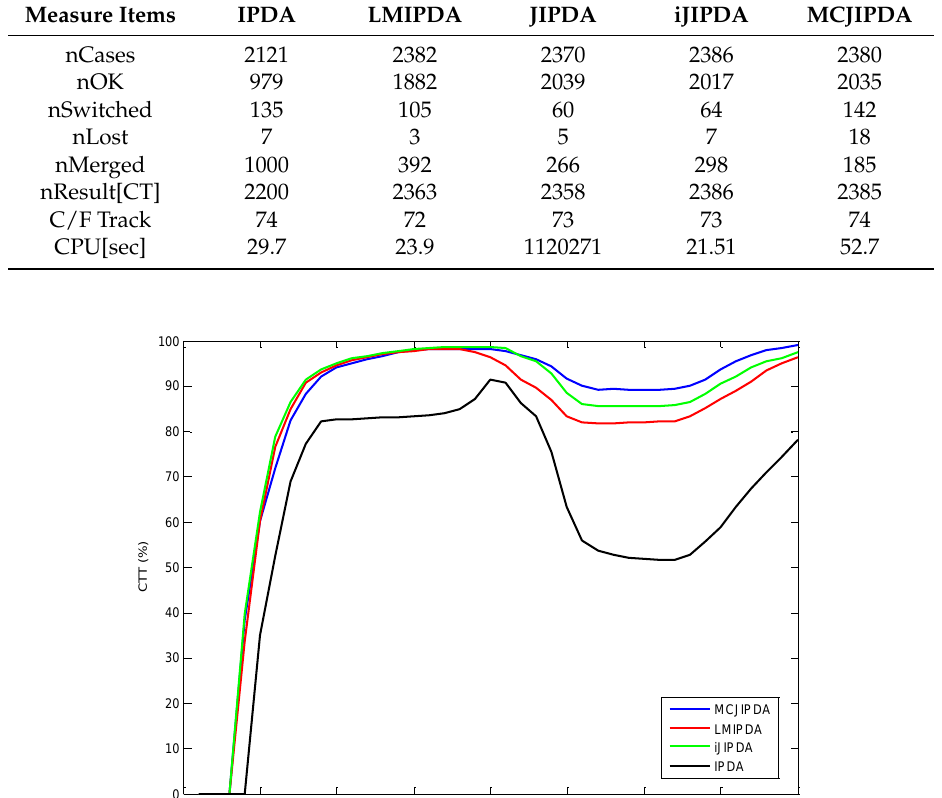
Figure 7. The confirmed true tracks rate for Case #2.